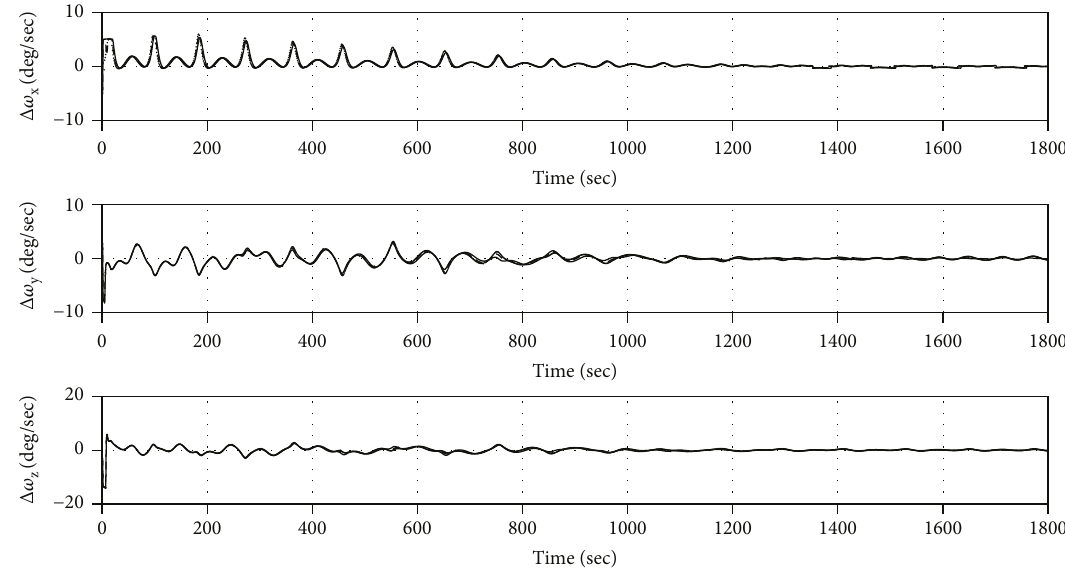
J J x and y (dotted